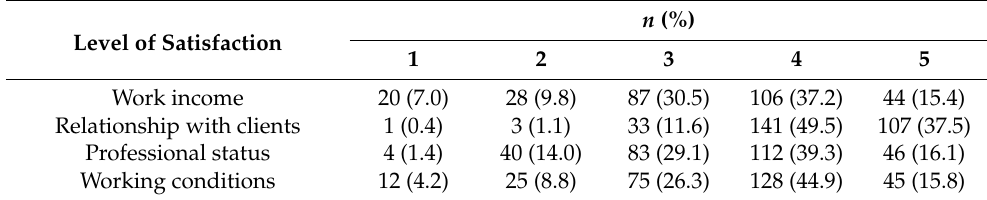
Table 2. Level of job satisfaction.